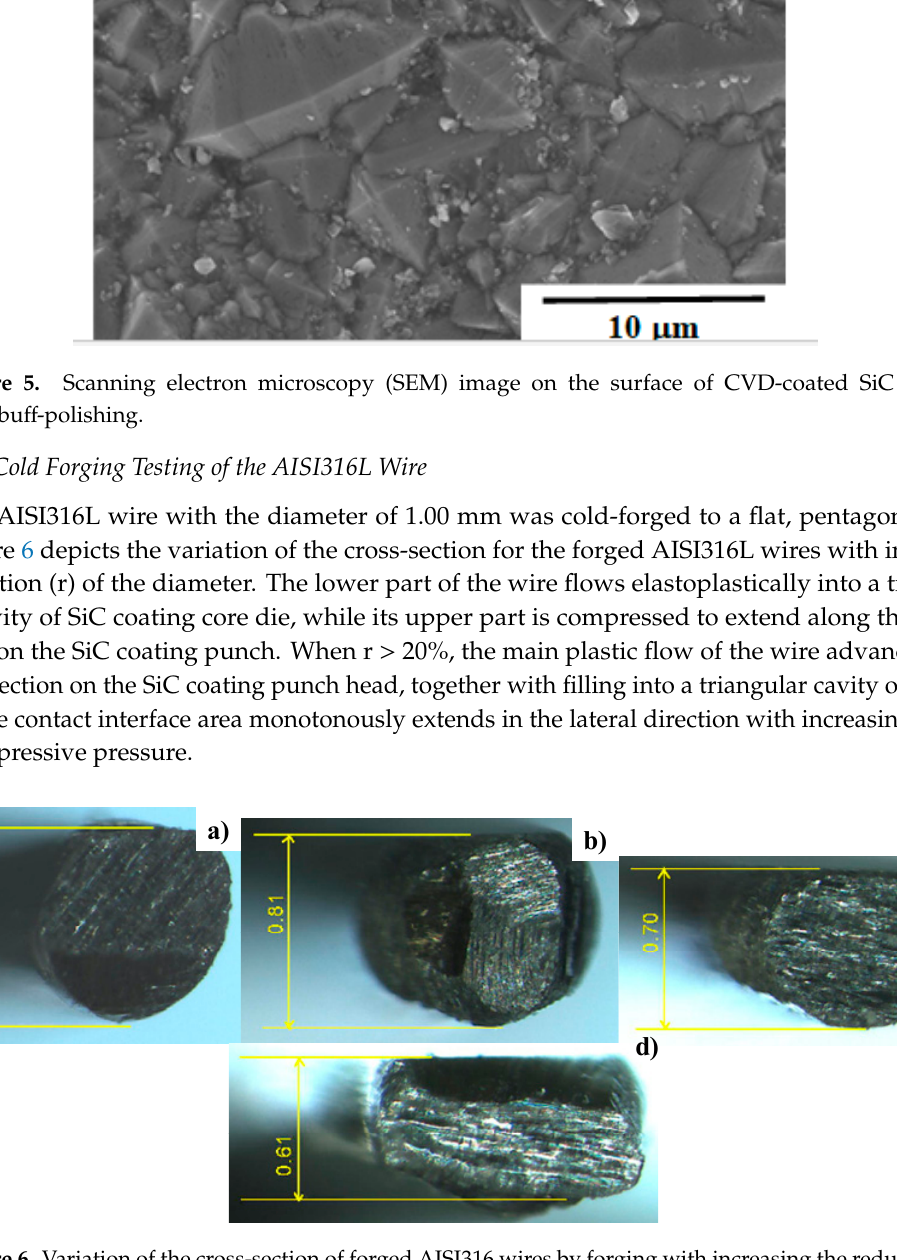
Figure 6. Variation of the cross-section of forged AISI316 wires by forging with increasing the reduction of the diameter. ( a ) r = 10%, ( b ) r = 20%, ( c ) r = 30% and ( d ) r = 40%.